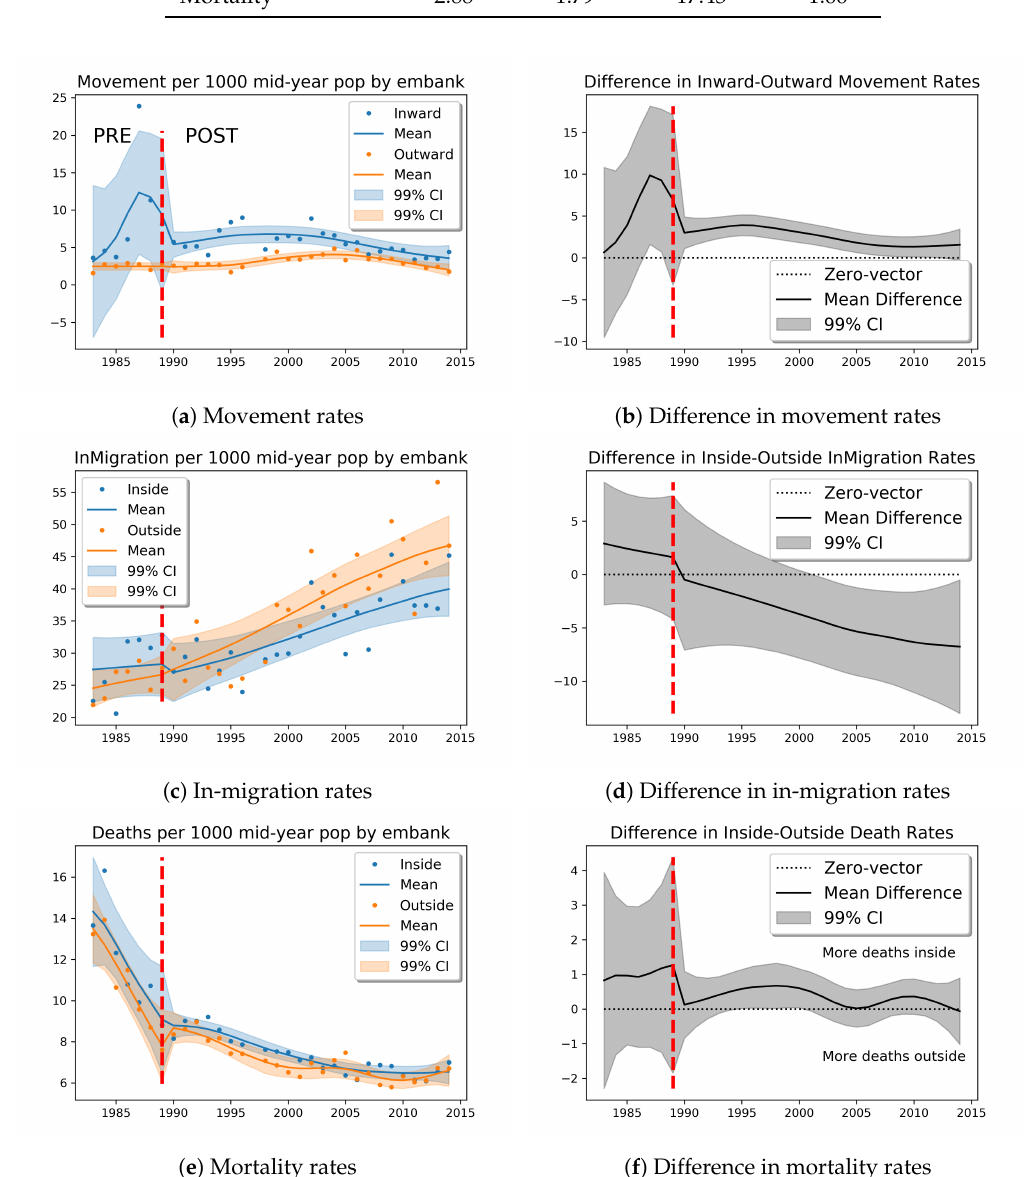
Figure 4. Analysis of temporal difference for three specific events— ( a , b ) inward/outward movement, ( c , d ) inside/outside in-migration, and ( e , f ) inside/outside mortality during 1983–2014. For each case, the left column shows the individual time-series modeled by GP, and the right column shows the estimated differences in two time-series. The red dashed line marks the pre- and post-embankment